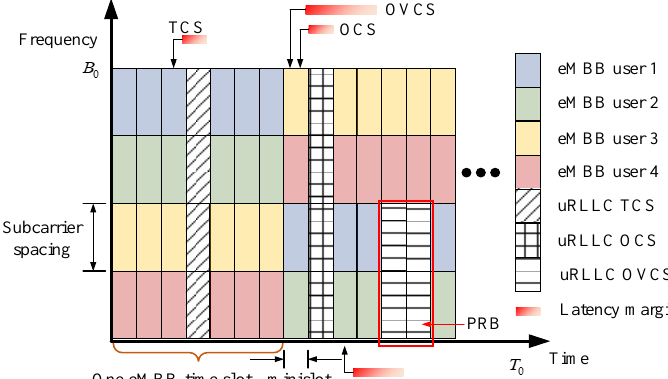
Figure 8. The diagram of the physical resource multiplexing of the eMBB and uRLLC.